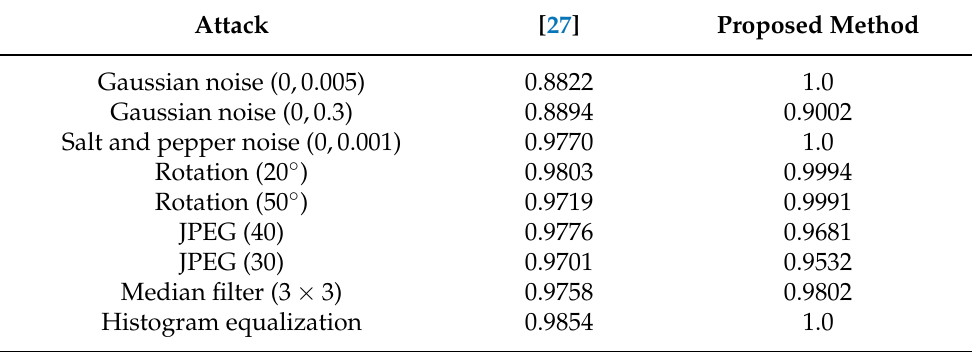
Table 14. Robustness comparison measured with [27] in terms of NC for Lena image.